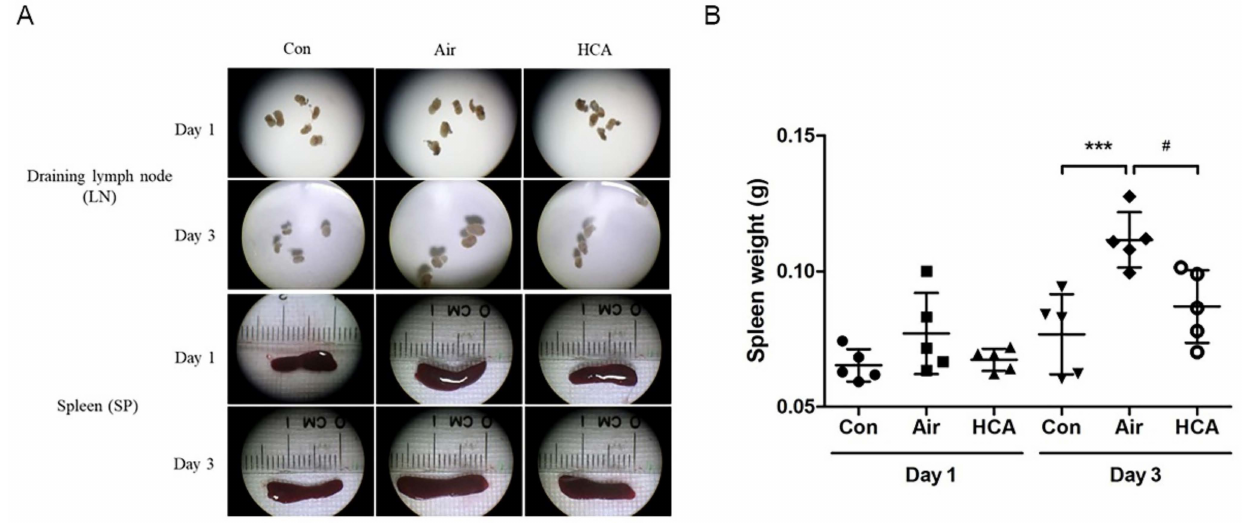
Figure 4. Macroscopic images of draining lymph nodes and spleens after transplantation. ( A ) The representative photographs of draining lymph nodes and spleen size are shown for recipient mice after receiving skin allografts. ( B ) Spleen weight was measured on days 1 and 3 post-skin graft ( n = 5 mice/group). *** p < 0.001 compared with Con group; # p < 0.05 compared with Air group.